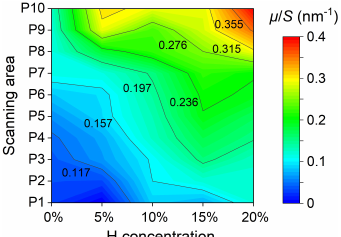
Figure 6. The ratio between friction coefficient and surface roughness ( µ / S ) of ten random areas for each hydrogen